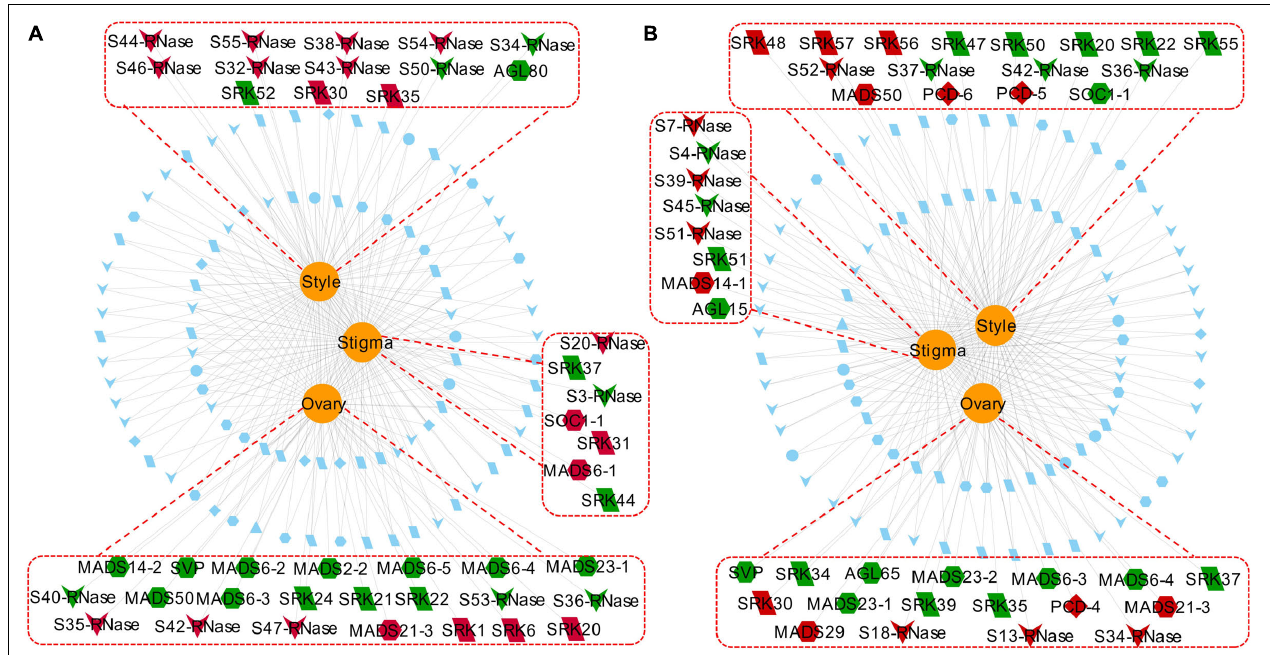
FIGURE 11 | Network showing commonly and specifically expressed PCD genes (PCD1–PCD8) and three groups of PCD-related genes (4CL, S-RNase, and MADS-box) in different floral tissues (stigma, style, and ovary). Red dotted lines and rectangles indicate genes specifically expressed in the corresponding tissue. Edges represent target genes by the corresponding tissue, in which red nodes indicate up-regulated genes while green nodes indicate down-regulated genes. Blue nodes represent genes expressed in common across tissues. (A) Tenera-vs-Seedless. (B) Pisifera-vs-Seedless. Nodes: PCD, diamond; 4CL, ellipse; S-RNase, V-shaped; MADS-box, hexagon; SLG, triangle; SRK, parallelogram.